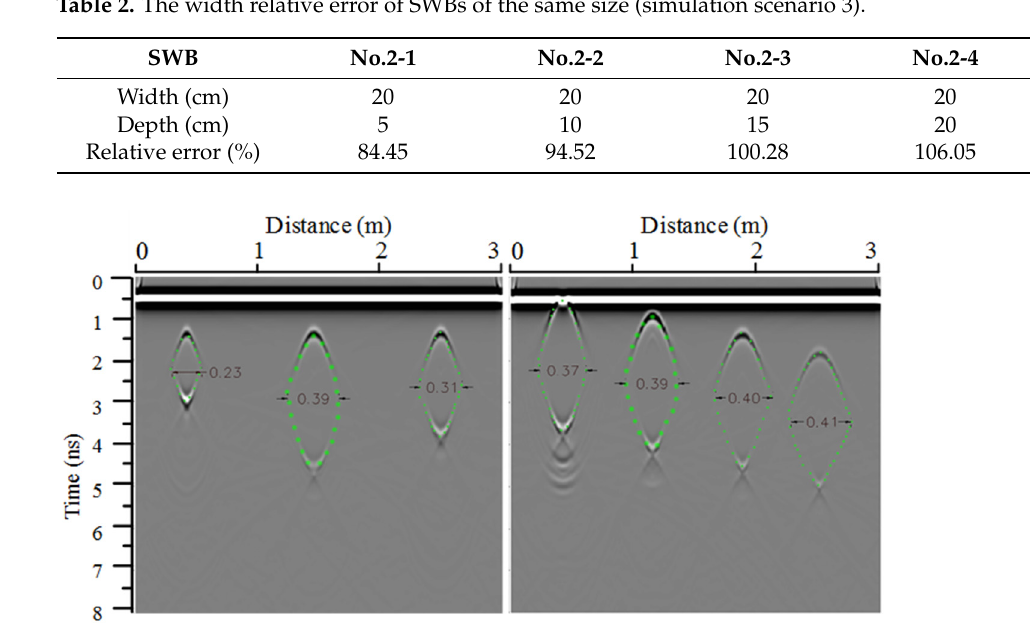
Figure 8. Simulated radargrams of subsurface SWBs of different depths: ( a ) The raw radargram; ( a- 1 ) the FK migration radargram.